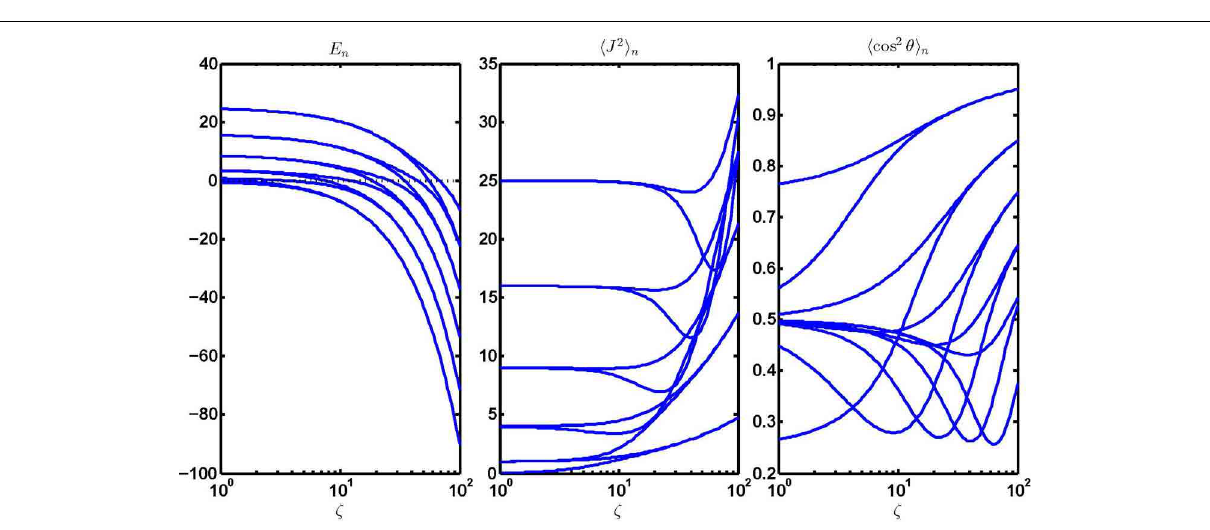
FIGURE 3 | Eigenproperties of the planar quantum pendulum subject to a purely aligning interaction as a function of the interaction parameter ζ . The three panels show the eigenenergies and the